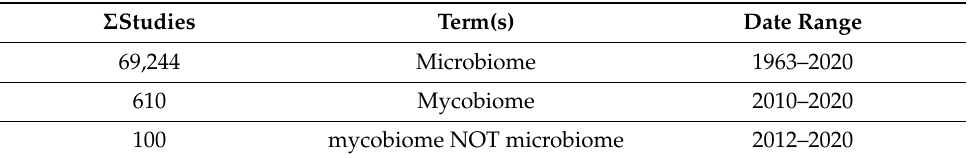
Table 1. Cumulative numbers of microbiome and mycobiome studies in PubMed on 11 June 2020. Search conducted using terms indicated.